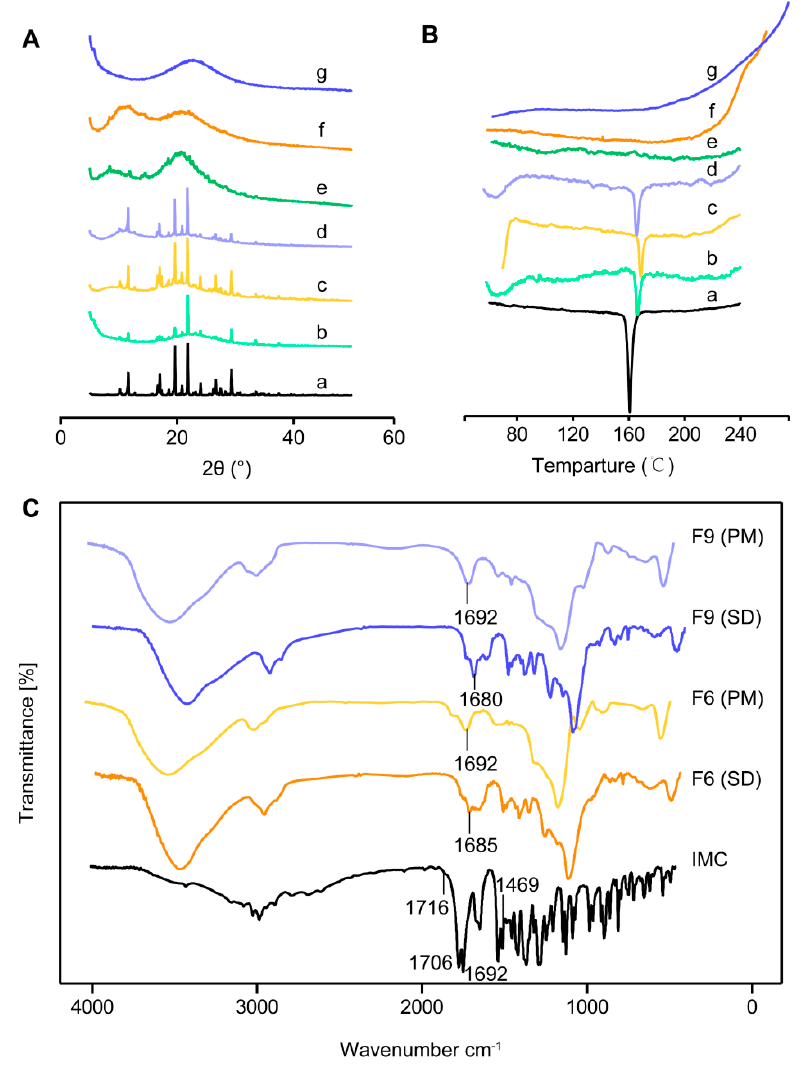
Figure 4. ( A ) PXRD patterns and ( B ) DSC curves of (a) IMC; (b) physical mixture (PM) of MSNs (F3); (c) PM of MSNs and Kollicoat IR (F6); (d) PM of MSNs and HPMC (F9); (e) IMC–MSNs (F3); (f) IMC–MSNs@Kollicoat IR (F6); and (g) IMC–MSNs@HPMC (F9). ( C ) IR spectra of pure IMC, IMC–SDs, and relative physical mixtures.